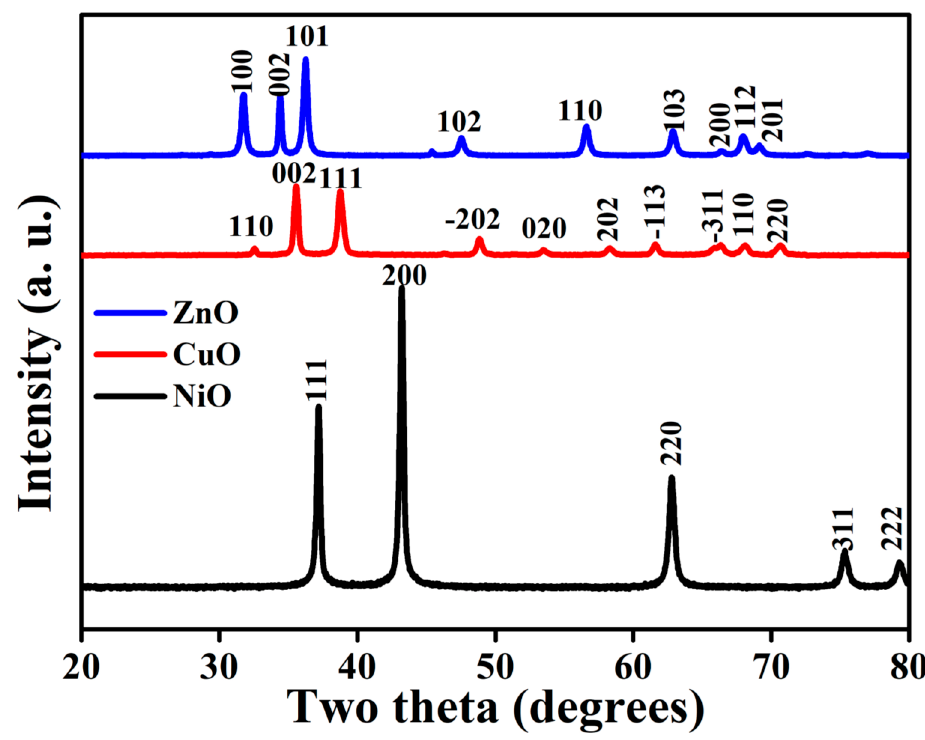
Figure 2. X-ray diffractogram of all the synthesized metal oxides (NiO, CuO, and ZnO). The monoclinic structure of CuO was confirmed by the diffraction pattern, and the planes that resembled the monoclinic structure (JCPDS: 80-1916) were (111), (202), (020), and (202), which corresponds to the 2 θ values of 38.6 ◦ , 48.8 ◦ , 53.3 ◦ , and 58.2 ◦ , respectively [7]. The XRD pattern showed great purity, and no impurity peaks besides CuO were found.